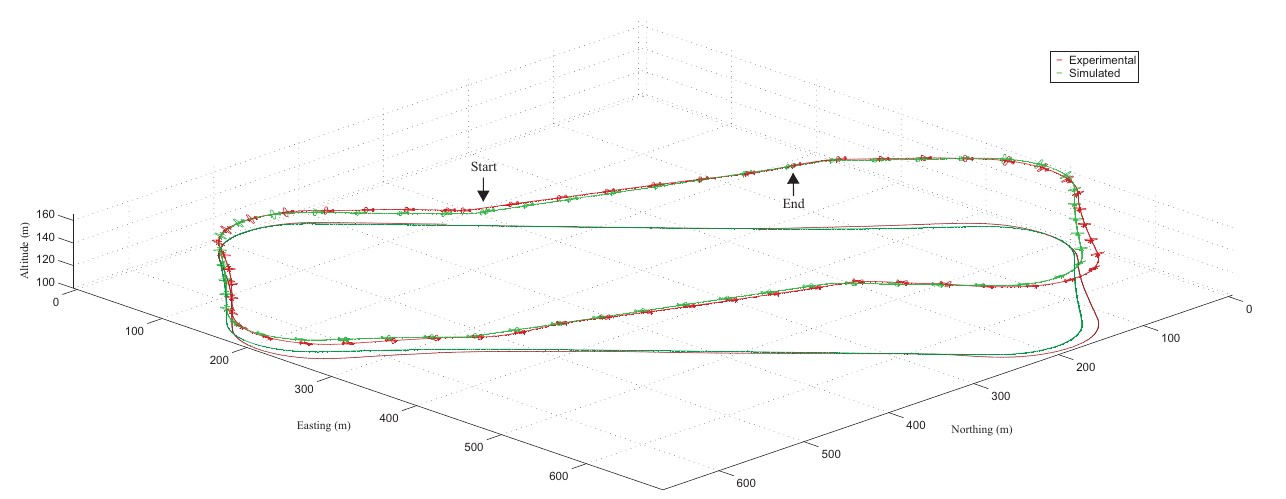
Figure 12. Comparison of aircraft path for experimental (red) and simulated flight (green) results; the aircraft is plotted every 2 s.